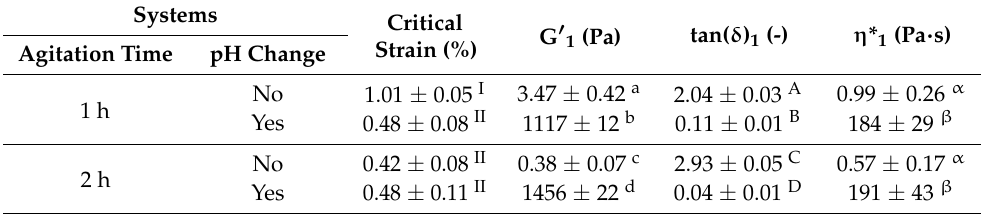
Table 2. Strain and frequency sweep tests parameters (mean value + standard deviation) for chitosan hydrogels processed at different agitation times (1 and 2 h) and without and with pH change gelatinized at 50 ◦ C. G (cid:48) 1 : elastic modulus at 1 Hz; tan δ 1 : loss tangent at 1 Hz; η * 1 : complex viscosity at 1